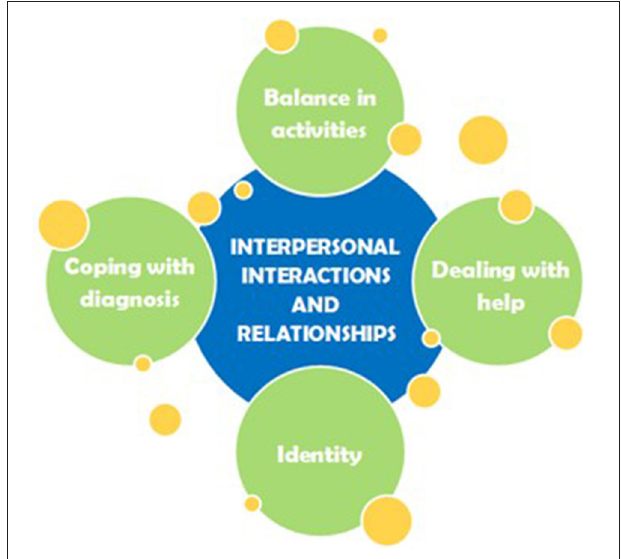
FIGURE 1 | The yellow circles show the aspects influencing interpersonal interactions and relationships that are